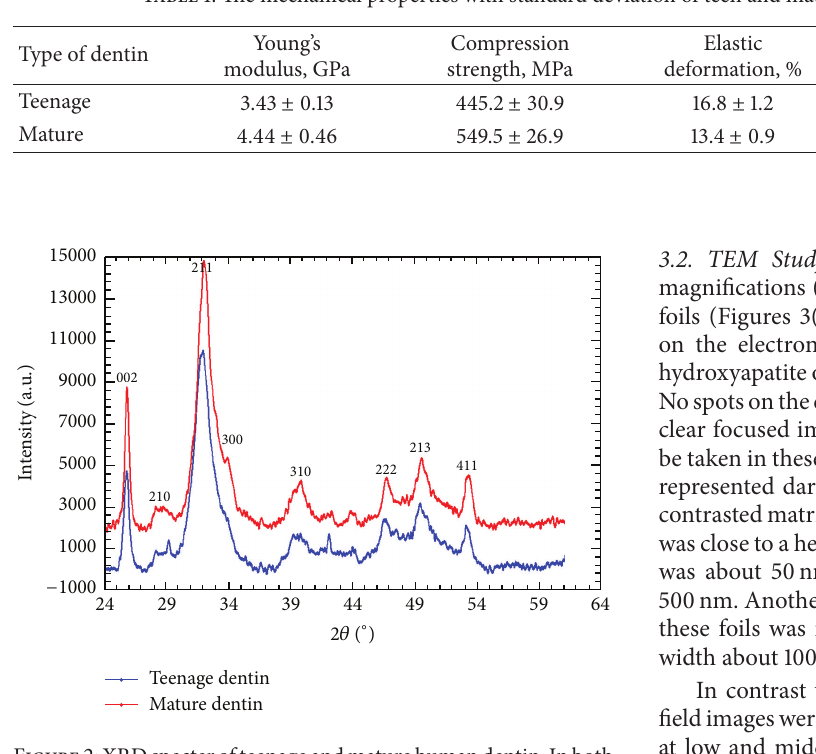
Figure2:XRDspecterofteenageandmaturehumandentin.Inboth cases human dentin is in X-ray amorphous